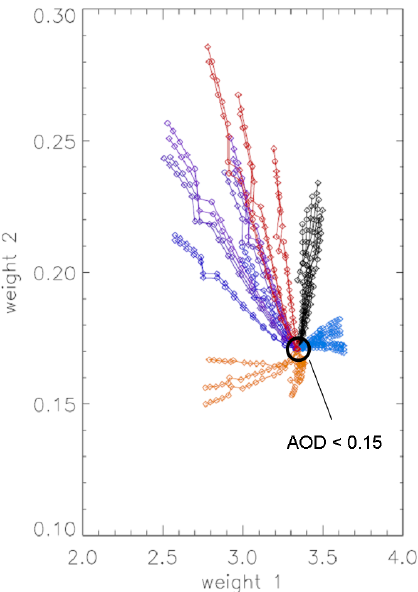
Fig. 4. Histogram for various scenarios (y-axis) of the number of DFS of SYNAER reflectance measurements using different observation errors for spectrum measurements. The black histogram corresponds to observational measurement variance σ 2 =10e-6, yellow corresponds to σ 2 = 6e-7, green line: σ 2 =5e-7, blue line: σ 2 =4e-7, violet line: σ 2 =3e-8. Large-step series of the error: 10e-6, 6e-7, 3e-8 and small-step series of the observation error: 4e-7, 5e-7, 6e-7 correspondingly.